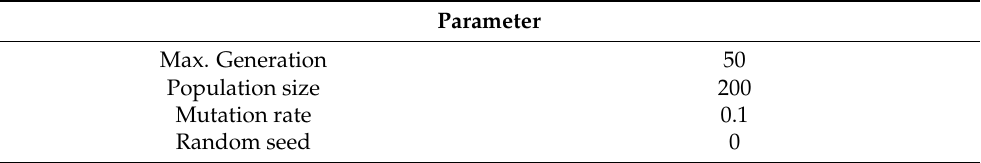
Table 5. GA Parameter.